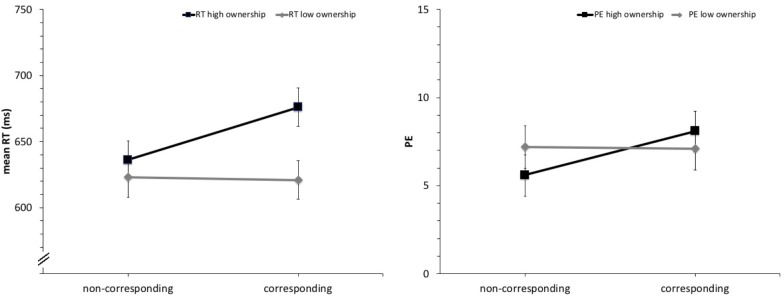
Mean reaction times (RTs) and percentage errors (PEs) as a function of spatial correspondence and instruction (high vs. low ownership). Error bars represent 95% within-subject CIs (Morey, 2008).